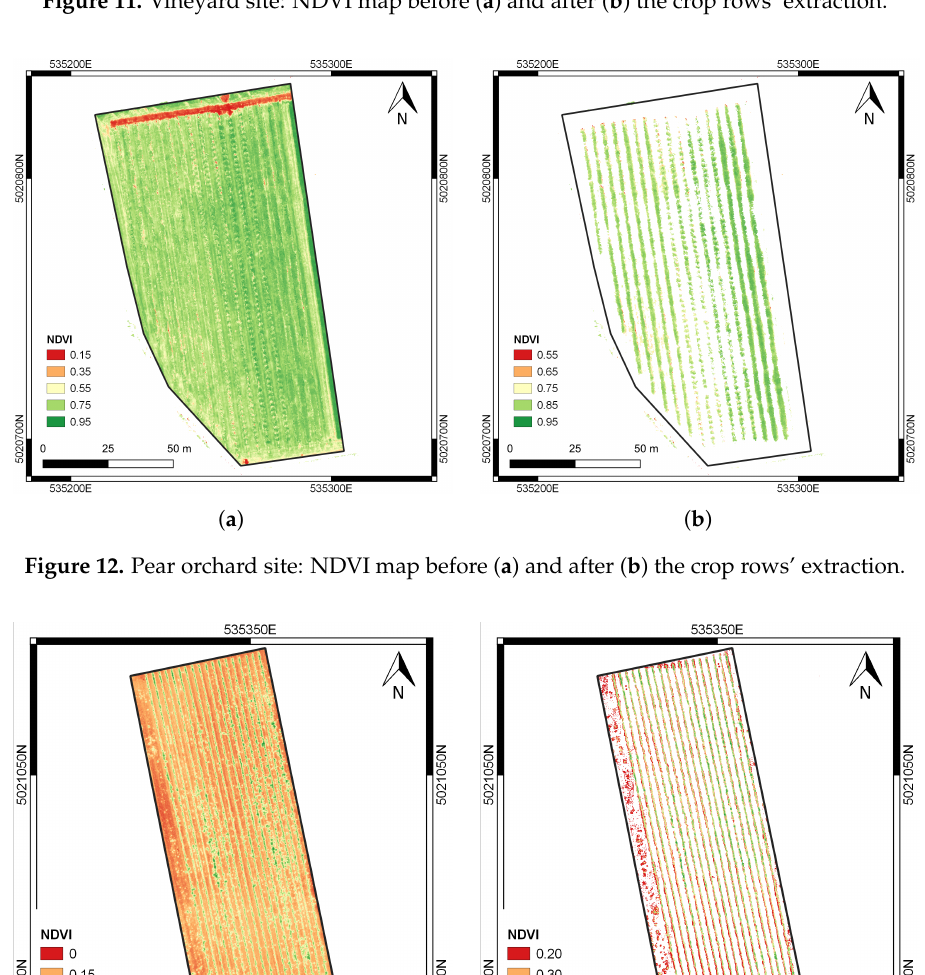
Figure 11. Vineyard site: NDVI map before ( a ) and after ( b ) the crop rows’ extraction.